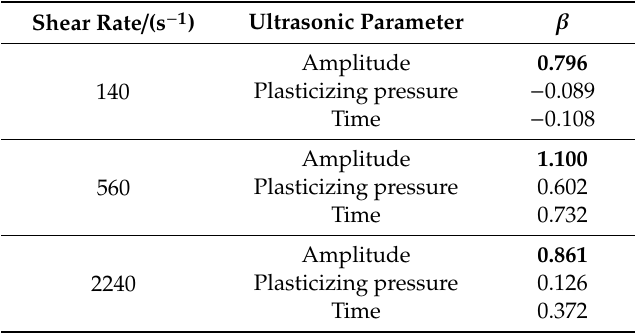
Table 9. MLRA results for Mode